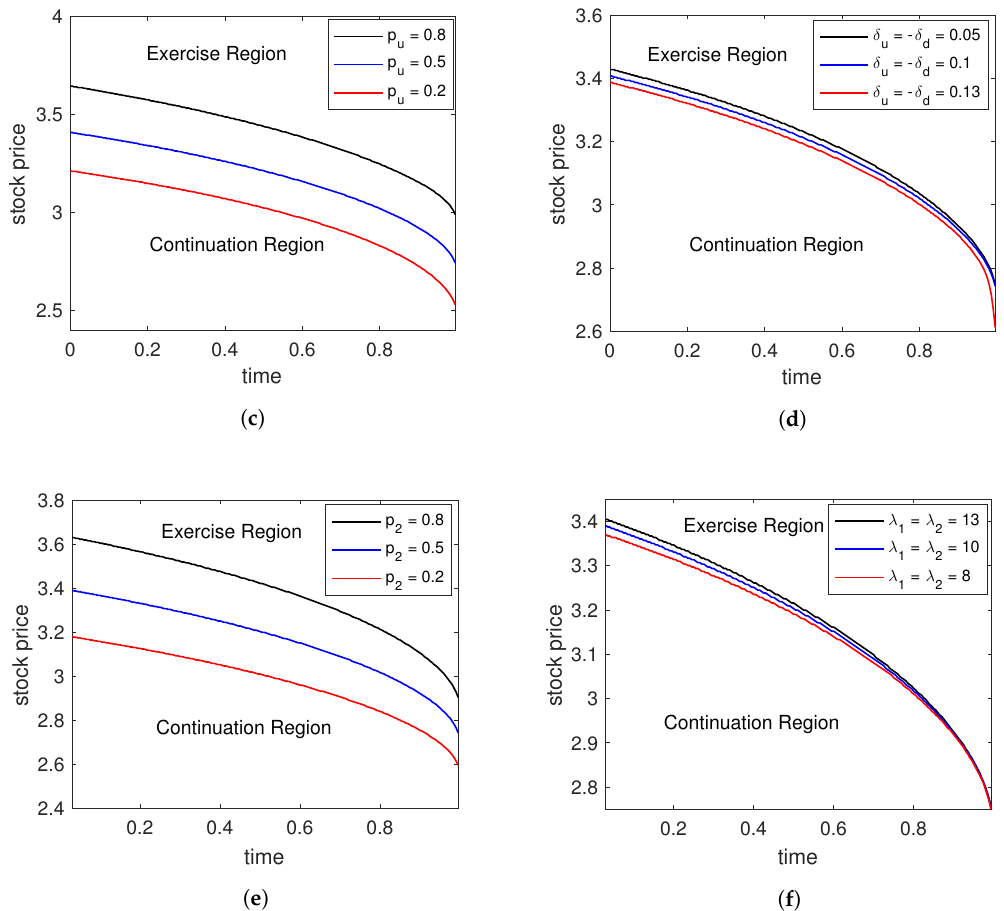
Figure 4. Optimal trading boundaries for stock liquidation under the two-point discrete distribution ( a , b ), normal distribution ( c , d ) and double exponential distribution ( e , f ). Parameters: ( a ) σ D = 0.2; ( b ) µ = 0; ( c ) δ u = − δ d = 0.1; ( d ) p u = p d = 0.5; ( e ) λ 1 = λ 2 = 10; ( f ) p 1 = p 2 = 0.5. Other common parameters are the same as Figure 3.